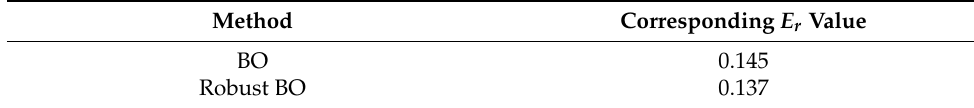
Table 2. Median across 16 replications.